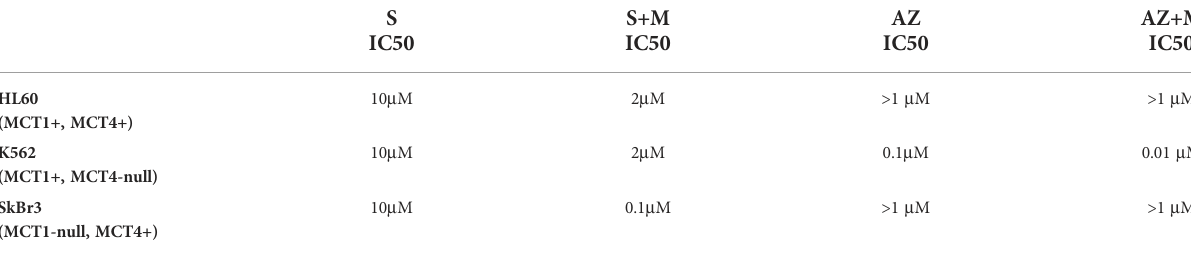
TABLE 1 In vitro IC50 of syrosingopine (S) and AZD3965 (AZ) in a panel of human cancer cell lines with varying MCT1 and MCT4 expression